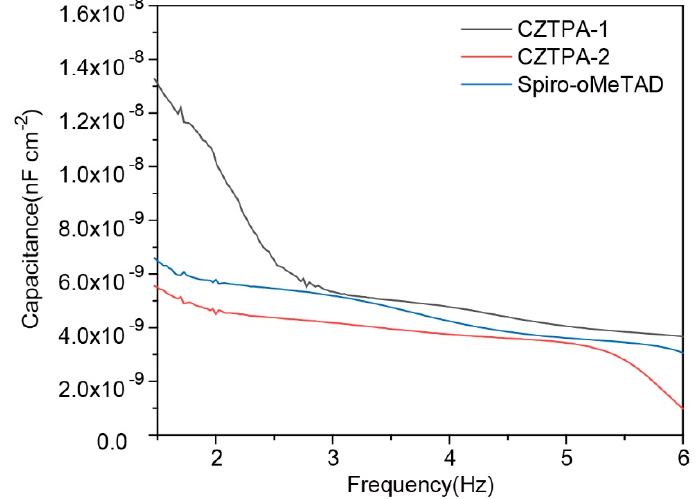
Figure 6. Capacitance versus frequency based on the devices of ITO/SnO 2